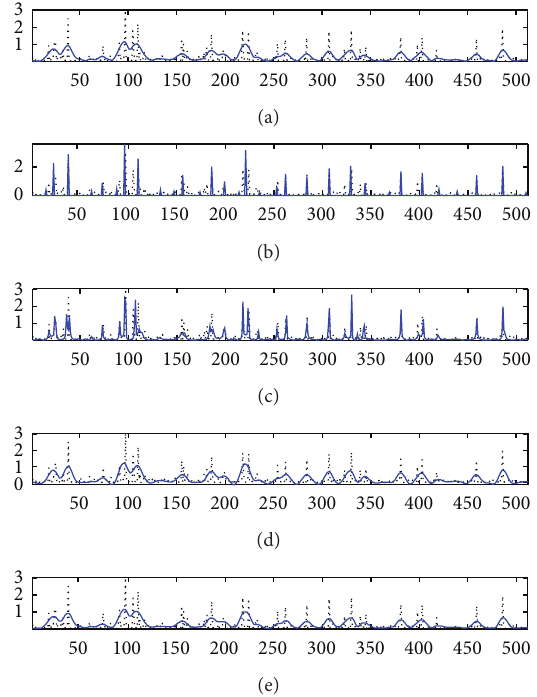
𝑙 𝜆 = 0.2 , for Wiener filter (also known as Tikhonov 1 -norm regularization) 𝜆 = 0.08 , and for TV-norm 𝜆 = 0.14 .